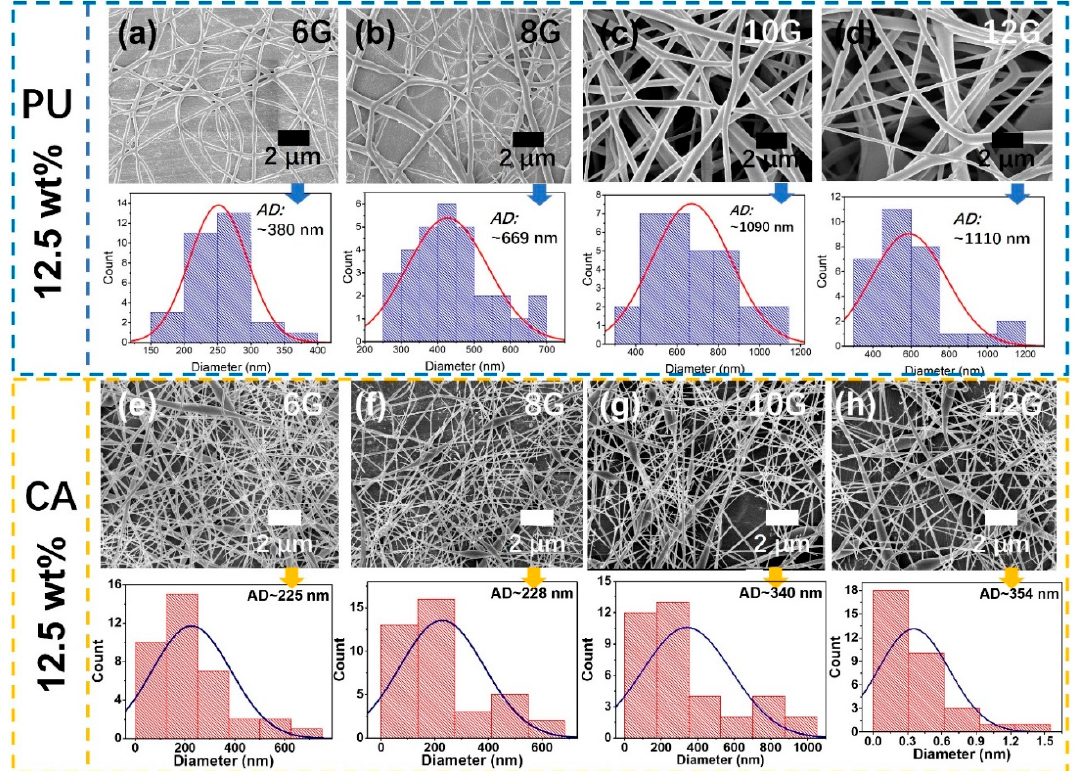
Figure3. SEMimagesandstatisticaveragediametersofPUandCAfibrousmembrane. Theconcentrations Figure 3. SEM images and statistic average diameters of PU and CA fibrous membrane. The of both PU and CA electrospun solution are 12.5 wt %, respectively. ( a – d ) SEM images of PU-6G, PU-8G, concentrations of both PU and CA electrospun solution are 12.5 wt%, respectively. ( a – d ) SEM images PU-10G, and PU-12G electrospun fibrous membranes. The statistic average fiber diameters (AD) are of PU-6G, PU-8G, PU-10G, and PU-12G electrospun fibrous membranes. The statistic average fiber 380 nm, 669 nm, 1090 nm, and 1110 nm, respectively (Bar: 2 µ m). ( e – h ) SEM images of CA-6G, CA-8G, diameters (AD) are 380 nm, 669 nm, 1090 nm, and 1110 nm, respectively (Bar: 2 μ m). ( e – h ) SEM CA-10G, and CA-12G electrospun fibrous membranes. The AD are 225 nm, 228 nm, 340 nm, and 354 images of CA-6G, CA-8G, CA-10G, and CA-12G electrospun fibrous membranes. The AD are 225 nm, nm, 228 nm, 340 nm, and 354 nm, respectively.